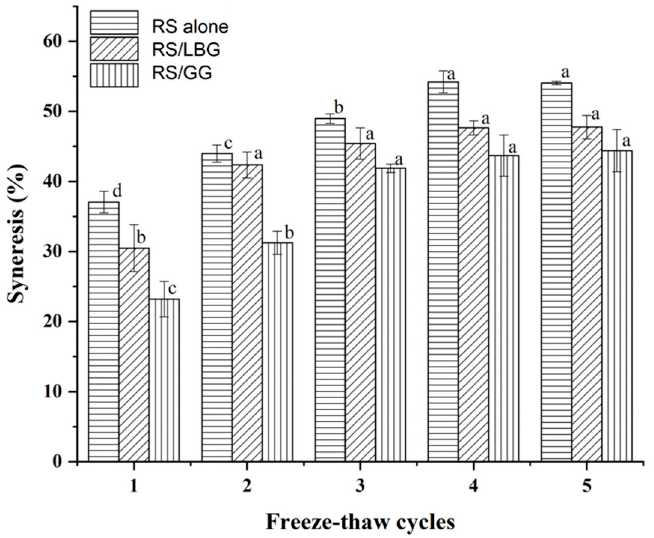
Figure 4. Freeze–thaw stability of RS alone, RS containing locust bean gum (RS/LBG), and RS containing guar gum (RS/GG). Different letters indicate significant differences among group ( p < 0.05 by Duncan’s multiple range test).